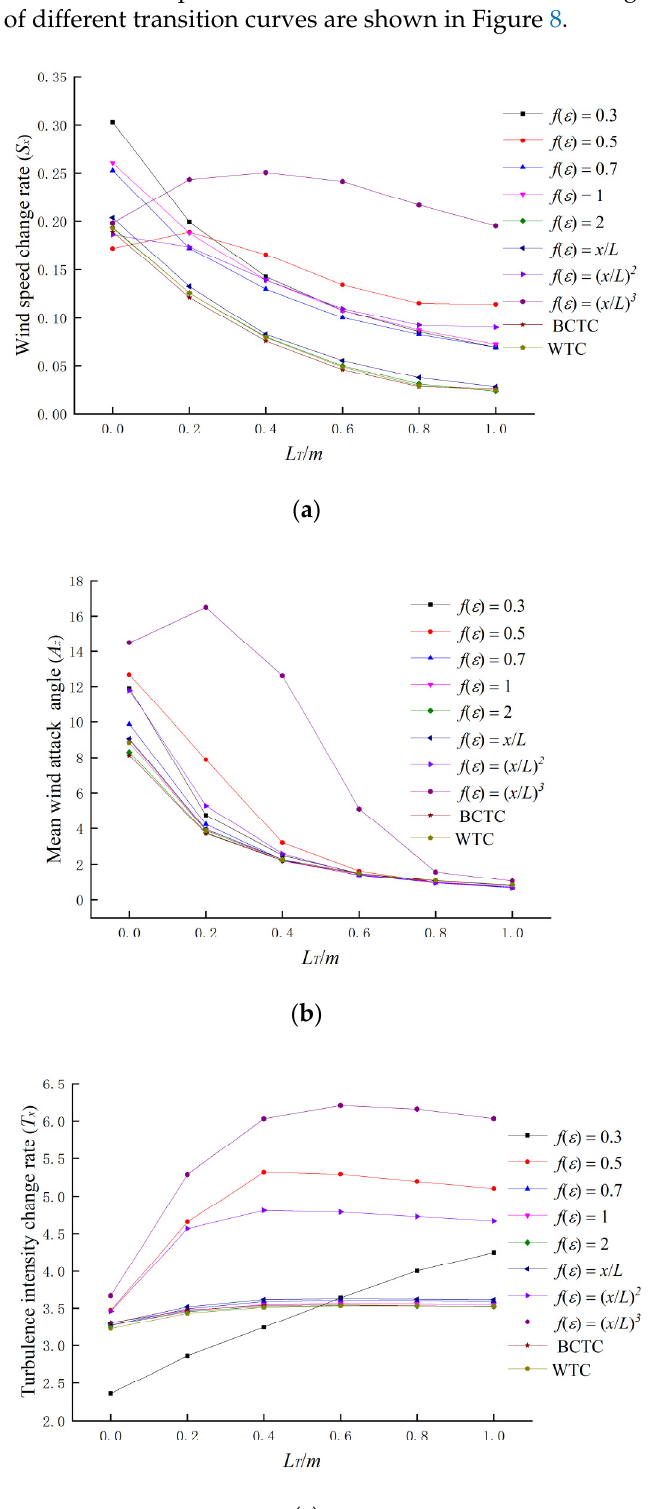
Figure 8. Wind speed variation rate, mean attack wind angle, and turbulence intensity variation rate for different transition curves. ( a ) Wind speed variation rate. ( b ) Mean attack wind angle. ( c ) Turbulence intensity variation rate.